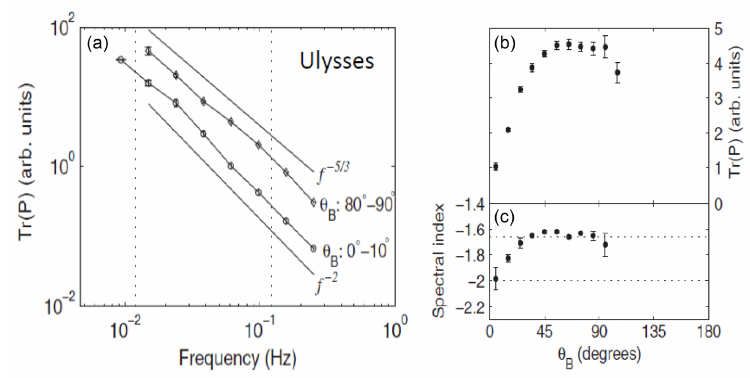
Figure 8. Anisotropy of turbulence spectra from Ulysses (Horbury et al., 2008) as a function of the angle θ B of the sampling direction with respect to the local mean magnetic field. (a) Spectra derived from the trace of the correlation matrix. (b) Mean amplitude and (c) spectral index as a function of the angle θ B . Note the the maximal power is observed for perpendicular (corresponding to k ⊥ ) sampling and the steepest spectrum for parallel (corresponding to k (cid:107) ) sampling.